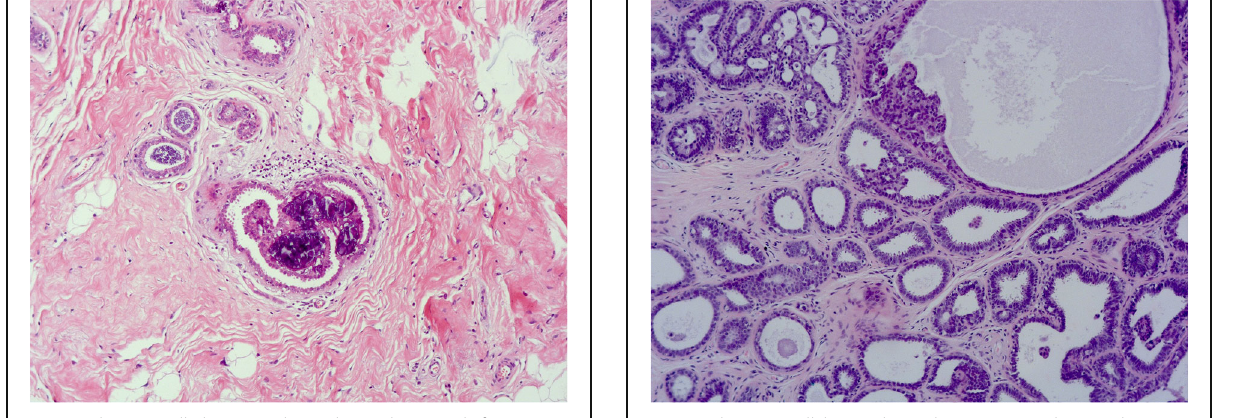
Fig. 2 Columnar cell change with intraluminal microcalcifications